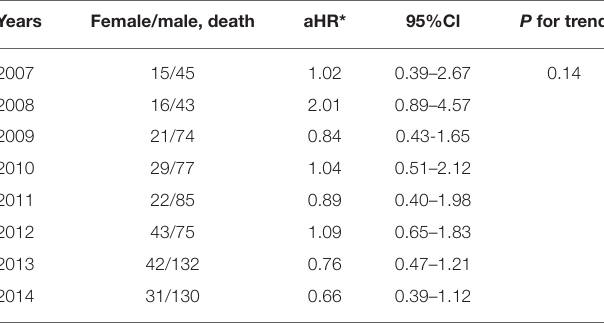
shown that men are the risk factors for coronary heart disease. TABLE 4 | Trend in 1-year Mortality